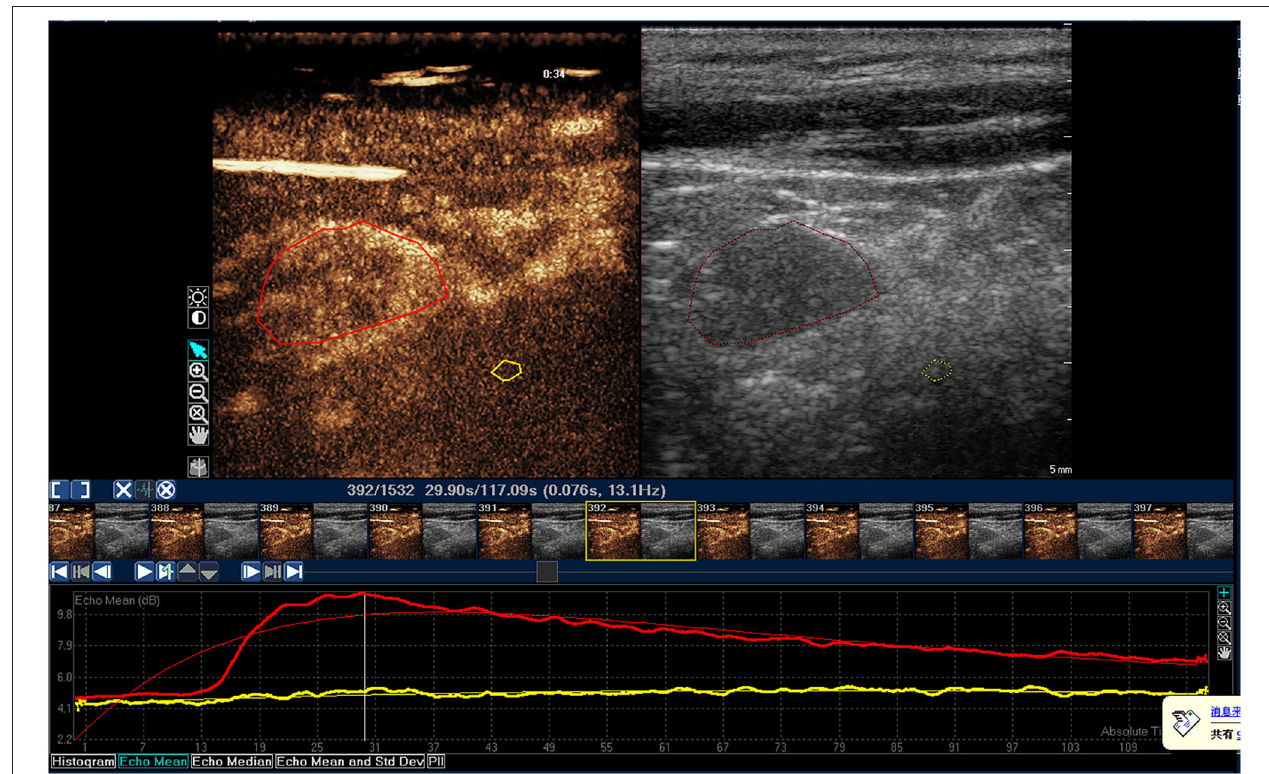
FIGURE 1 | Time-intensity curve of a typical benign lymph node in NPC patient. The red ROI is benign lymph node, and the red line is corresponding TIC curve. The yellow ROI is the tissue around the lesion, and the yellow line is the corresponding TIC curve. The benign lymph node was characterized by homogeneous